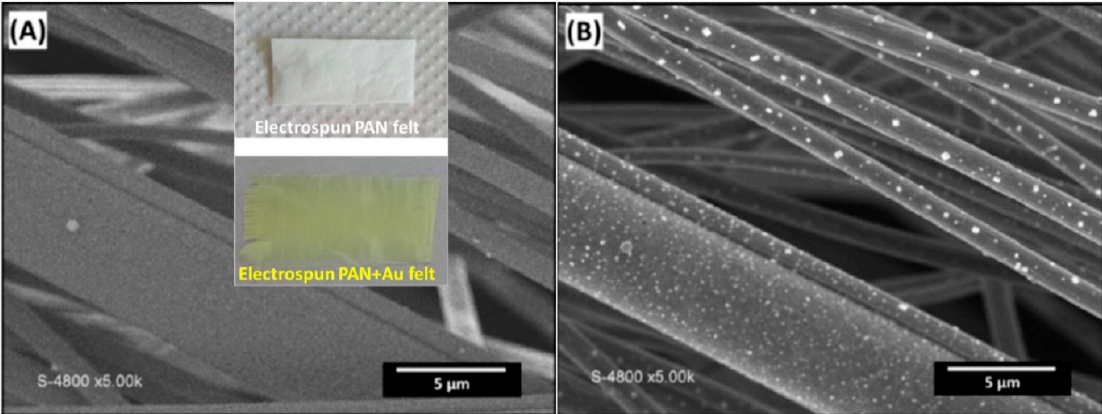
Figure 3. SEM images of Au@PAN fibers (insets are the tissues collected after electrospinning, yellowish for the presence of gold (III) salt) obtained with: ( A ) regular secondary electrons detector and ( B ) back-scattered electrons detector [34]. Reprinted and adapted with permission from ref. [34]; Copyright 2016, Wiley-VCH Verlag GmbH and Co. KGaA, Weinheim.